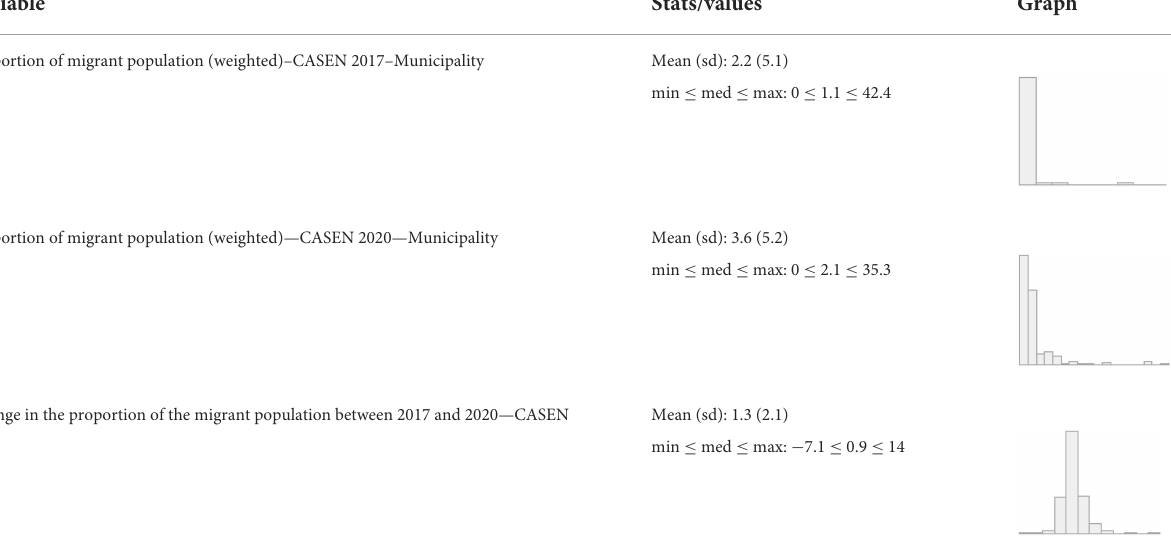
TABLE 4 Descriptive statistics of municipality data.